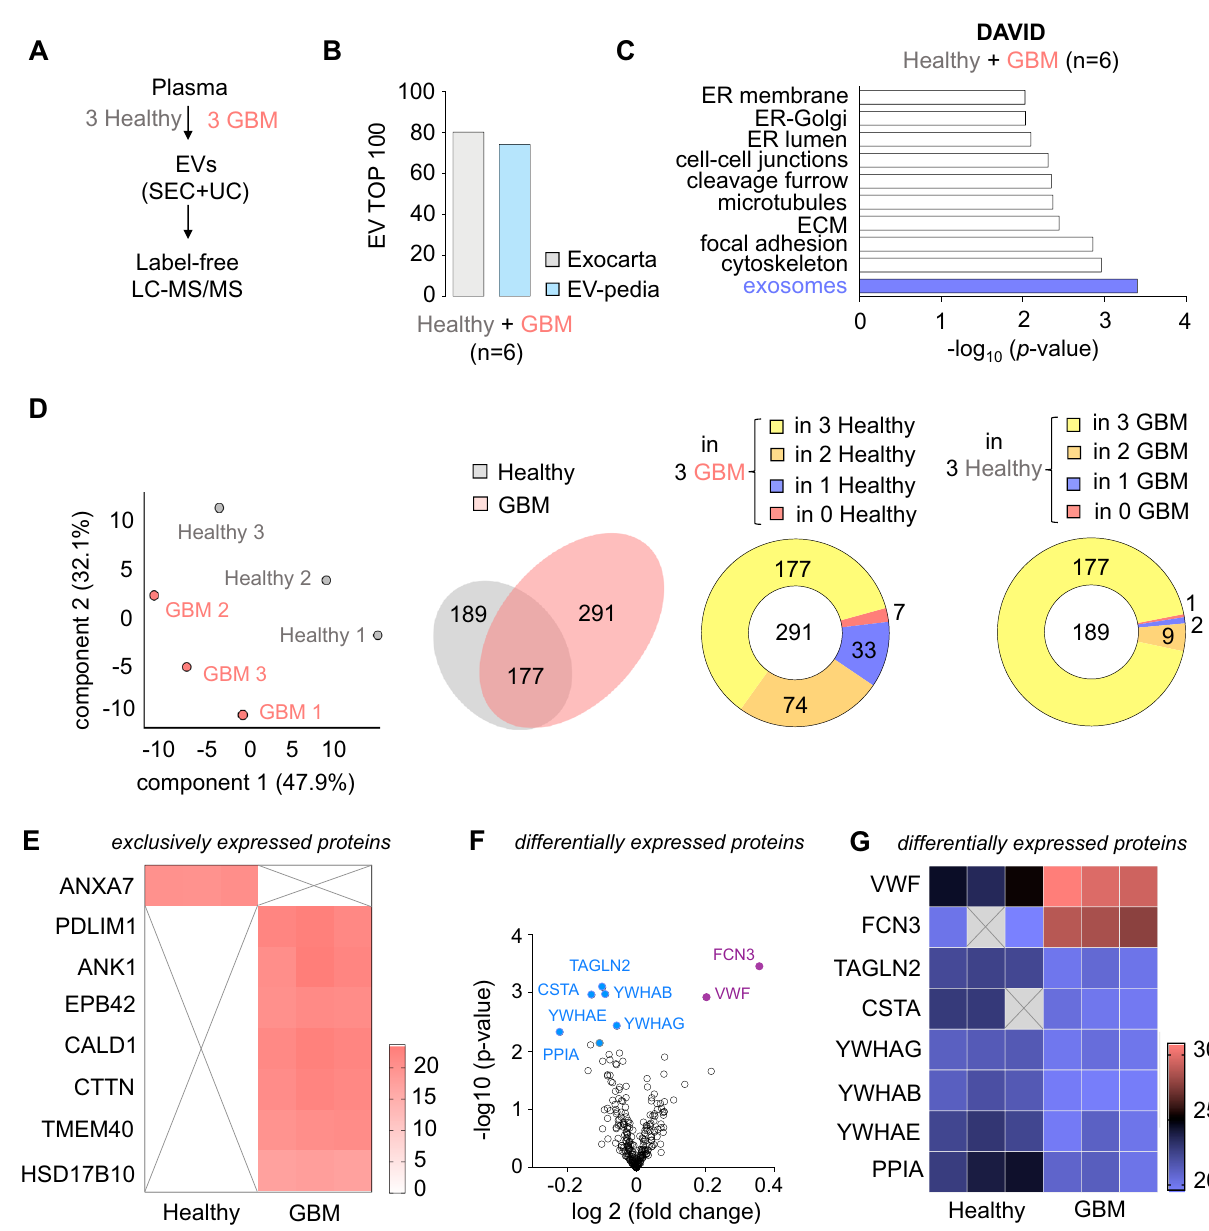
Figure 3. Proteomic analysis of circulating EVs from GBM patients unveils specific cargos. ( A ) Plasmatic extracellular vesicles (EVs) were separated from six plasmas (3 healthy donors and 3 GBM patients), as described in Fig. 1A. Protein cargoes were quantitatively analyzed through label-free liquid chromatography tandem mass spectrometry (LC–MS/MS). ( B ) Representation of the top 100 EV-enriched proteins estimated with Exocarta and EVpedia databases, when combining proteomic analysis from 6 samples. ( C ) DAVID analysis of the top Gene Ontology (GO) functions from the 6 analyzed samples. ( D ) Principal component analysis of healthy donors and GBM patient samples (left panel). Venn diagram of the detected proteins and their repartition between healthy donor and GBM patient groups (middle and right panel). ( E ) Heatmap analysis of exclusively expressed proteins. ( F , G ) Volcano plot and heatmap analysis of differentially expressed